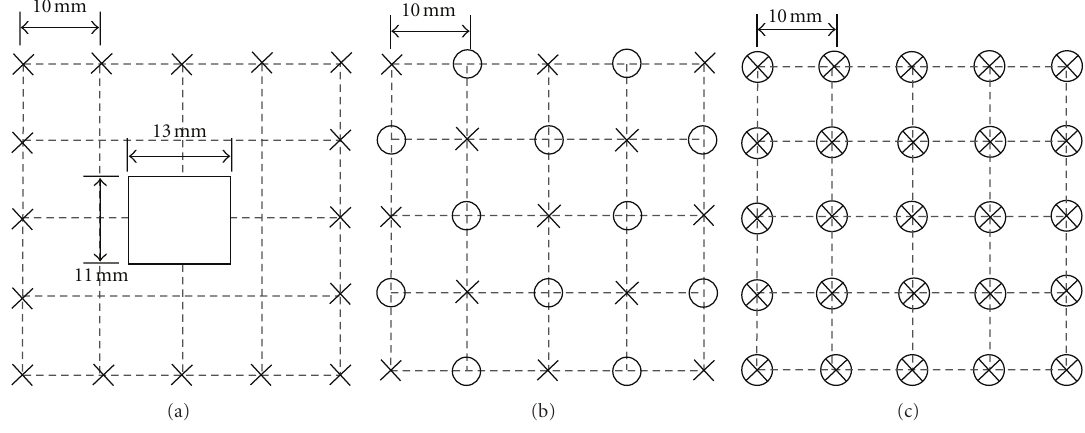
Figure 5: Scheme of optode geometries used in the simulation study. (a) to (c) are corresponded to G-I to G-III. Notice that the dimension of all dashed unit squares is 10 × 10 mm 2 . (x: source fibers; o: detector fibers;